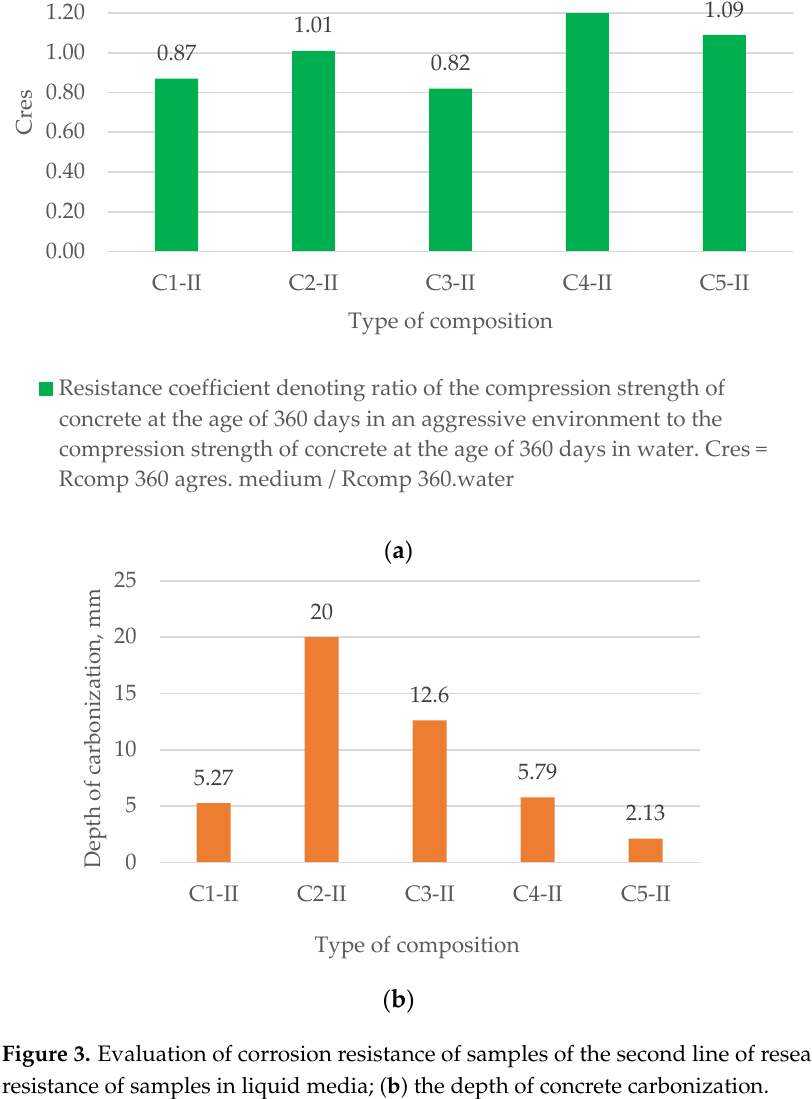
( b ) Figure 4. Contact layer “cement stone—aggregate” through a microscope: ( a ) composition C1-II; ( b ) composition C2-II. In the samples of composition С2-II shown in Figure 4b, we can clearly see outgrowths on the aggregate, in contrast to composition С1-II (Figure 4a). Thus, the use of a reactive aggregate based on waste from mineral wool production can be considered promising, since even with sufficiently low values for density and water resistance, this